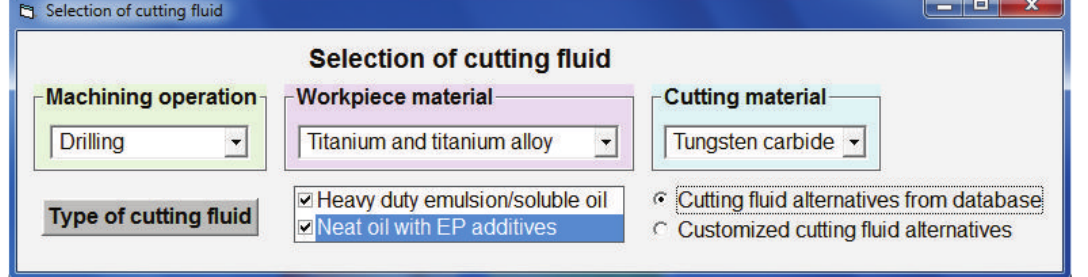
Figure 3: Opening window for Example